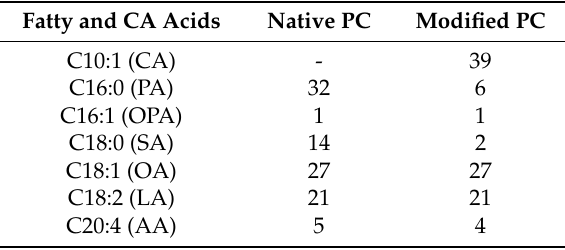
Table 1. Composition of fatty acids (wt %) of native egg-yolk PC and modified PC.